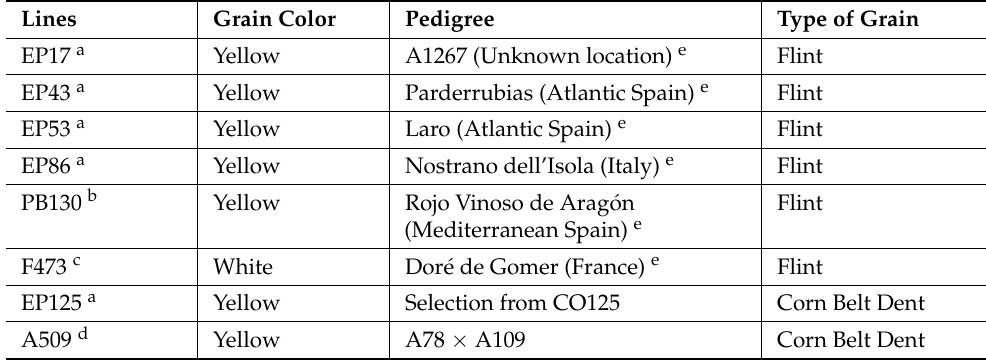
Table 5. Parental lines of the MAGIC population evaluated in this study. Lines Grain Color Pedigree Type of Grain EP17 a Yellow A1267 (Unknown location) e Flint EP43 a Yellow Parderrubias (Atlantic Spain) e Flint EP53 a Yellow Laro (Atlantic Spain) e Flint EP86 a Yellow Nostrano dell’Isola (Italy) e Flint PB130 b Yellow Rojo Vinoso de Arag ó n Flint (Mediterranean Spain) e F473 c White Dor é de Gomer (France) e Flint EP125 a Yellow Selection from CO125 Corn Belt Dent A509 d